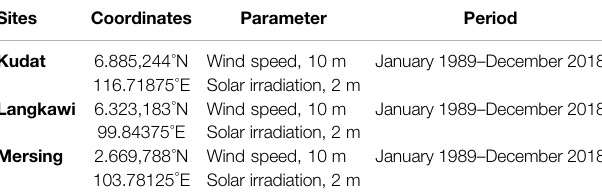
TABLE 1 | The coordinates, parameters, and periods of data at selected sites.